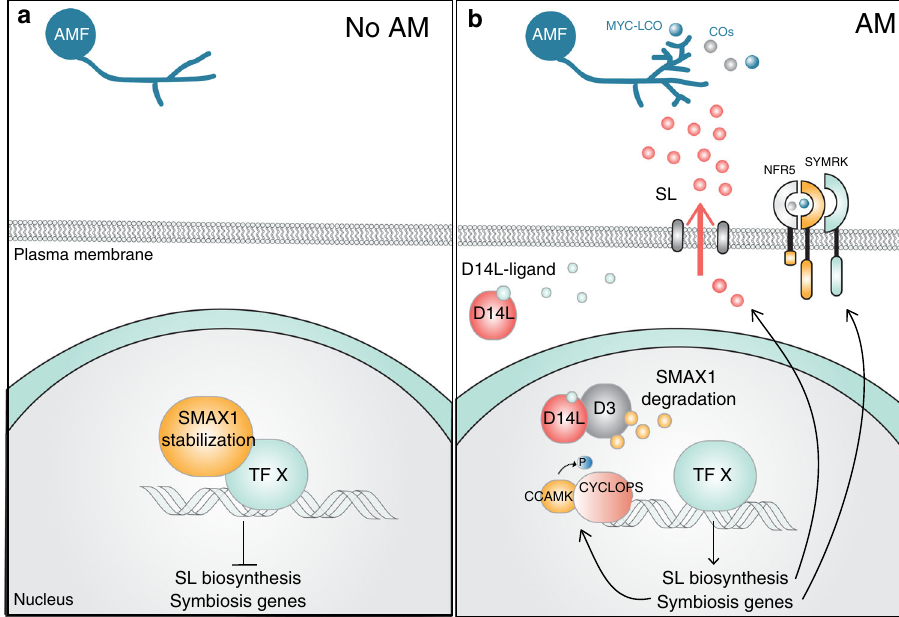
Fig. 5 Hypothetical model for the action of SMAX1 during AM symbiosis. The proposed model illustrates that SMAX1 is stabilised in d14l and d3 mutants, resulting in severely defective AM colonisation, suppressing transcription of symbiosis programmes. By contrast, in wild-type an unidenti fi ed D14L ligand binds to D14L, activating D14L signalling and degradation of SMAX1, thereby de-repressing relevant transcription factor/s. The symbiosis and SL biosynthesis genes are de-repressed enabling AM symbiosis and SL